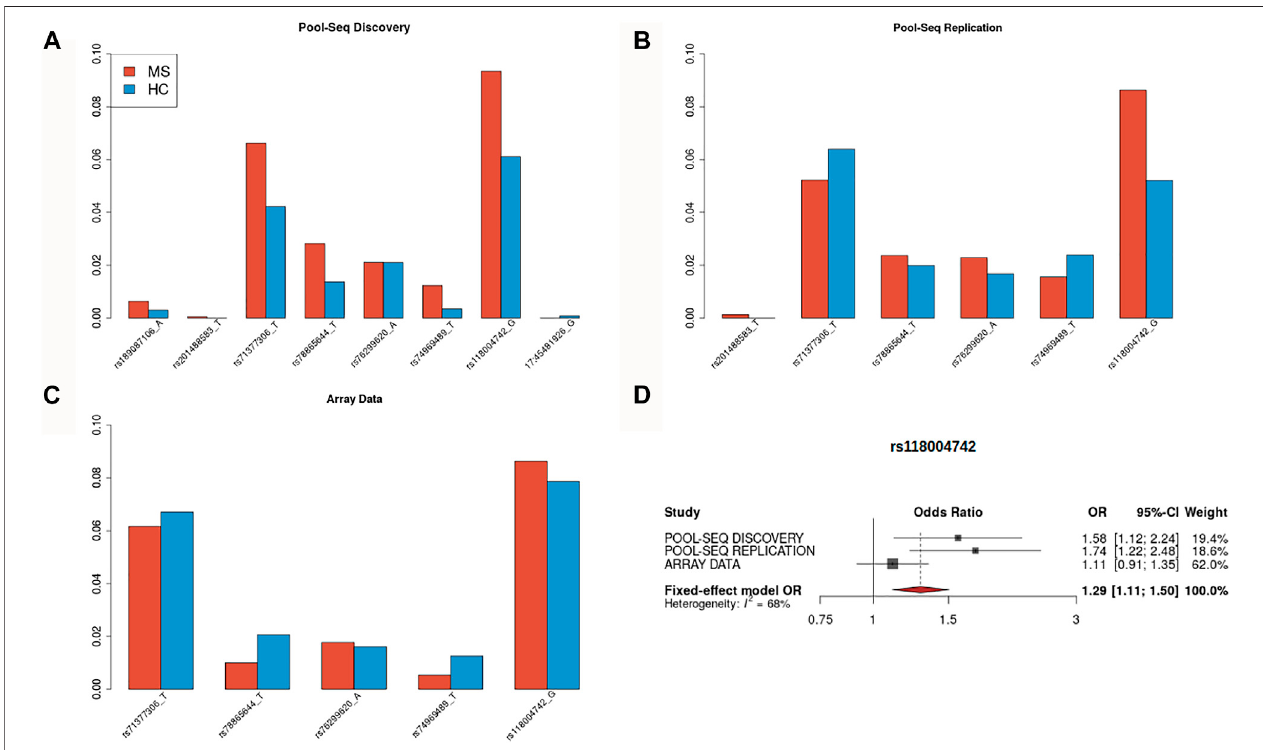
FIGURE 1 | Bar plots of minor allele frequency for EFCAB13 disruptive variants. Bar plots reporting minor allele frequencies for SNVs classi fi ed as disruptive (stop- loss, stop-gain, and splice site) located in the EFCAB13 gene for the three investigated cohorts. Red: MS patients, blue: healthy controls. (A) discovery cohort (N (cid:1)